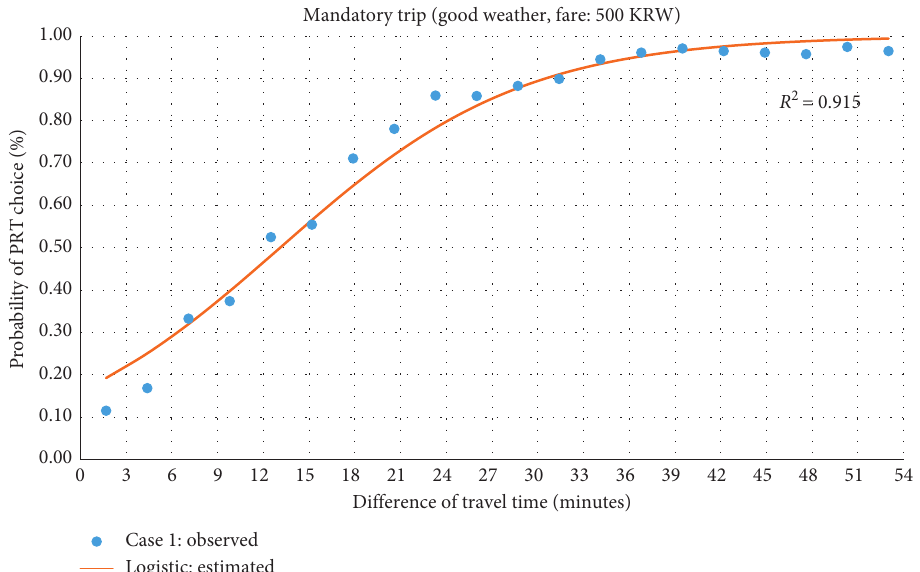
Figure 11: Logistic regression curve of the mandatory trip with 500 KRW under good weather (scenario 1).